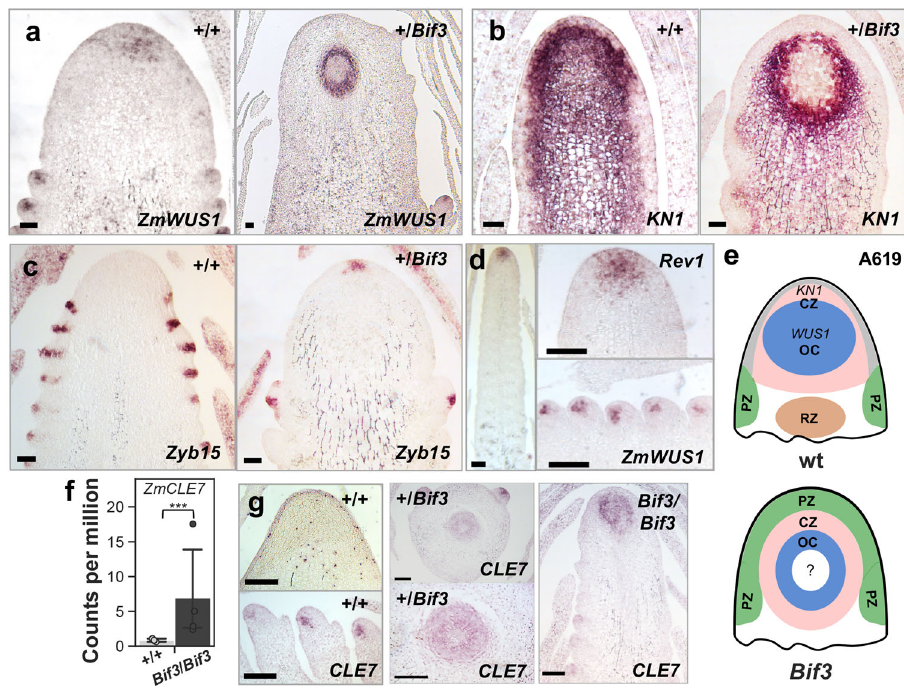
Fig. 4 Bif3 architectural rearrangements in in fl orescence meristems. a – d RNA in situ hybridizations of ZmWUS1 ( a , d ), KN1 ( b ) and ZYB15 ( c ) in Bif3 ear in fl orescence meristems (IMs). e Model of Bif3 IM structure. OC, organizing center; CZ, central zone; PZ, peripheral zone; RZ, rib zone. f Up-regulation of ZmCLE7 in Bif3 mutant RNA-seq data. Two-tailed Student ’ s t -test *** p < 0.001; plotted data represent mean ± standard deviation; n + pools of three ear samples). g Ectopic expression of ZmCLE7 is observed by in situ hybridizations on longitudinal ( + / + and Bif3/Bif3 ) and cross ( + / Bif3 ) sections of ear IMs. Scale bars: 50 μ m in ( a – c ); 100 μ m in ( d , g